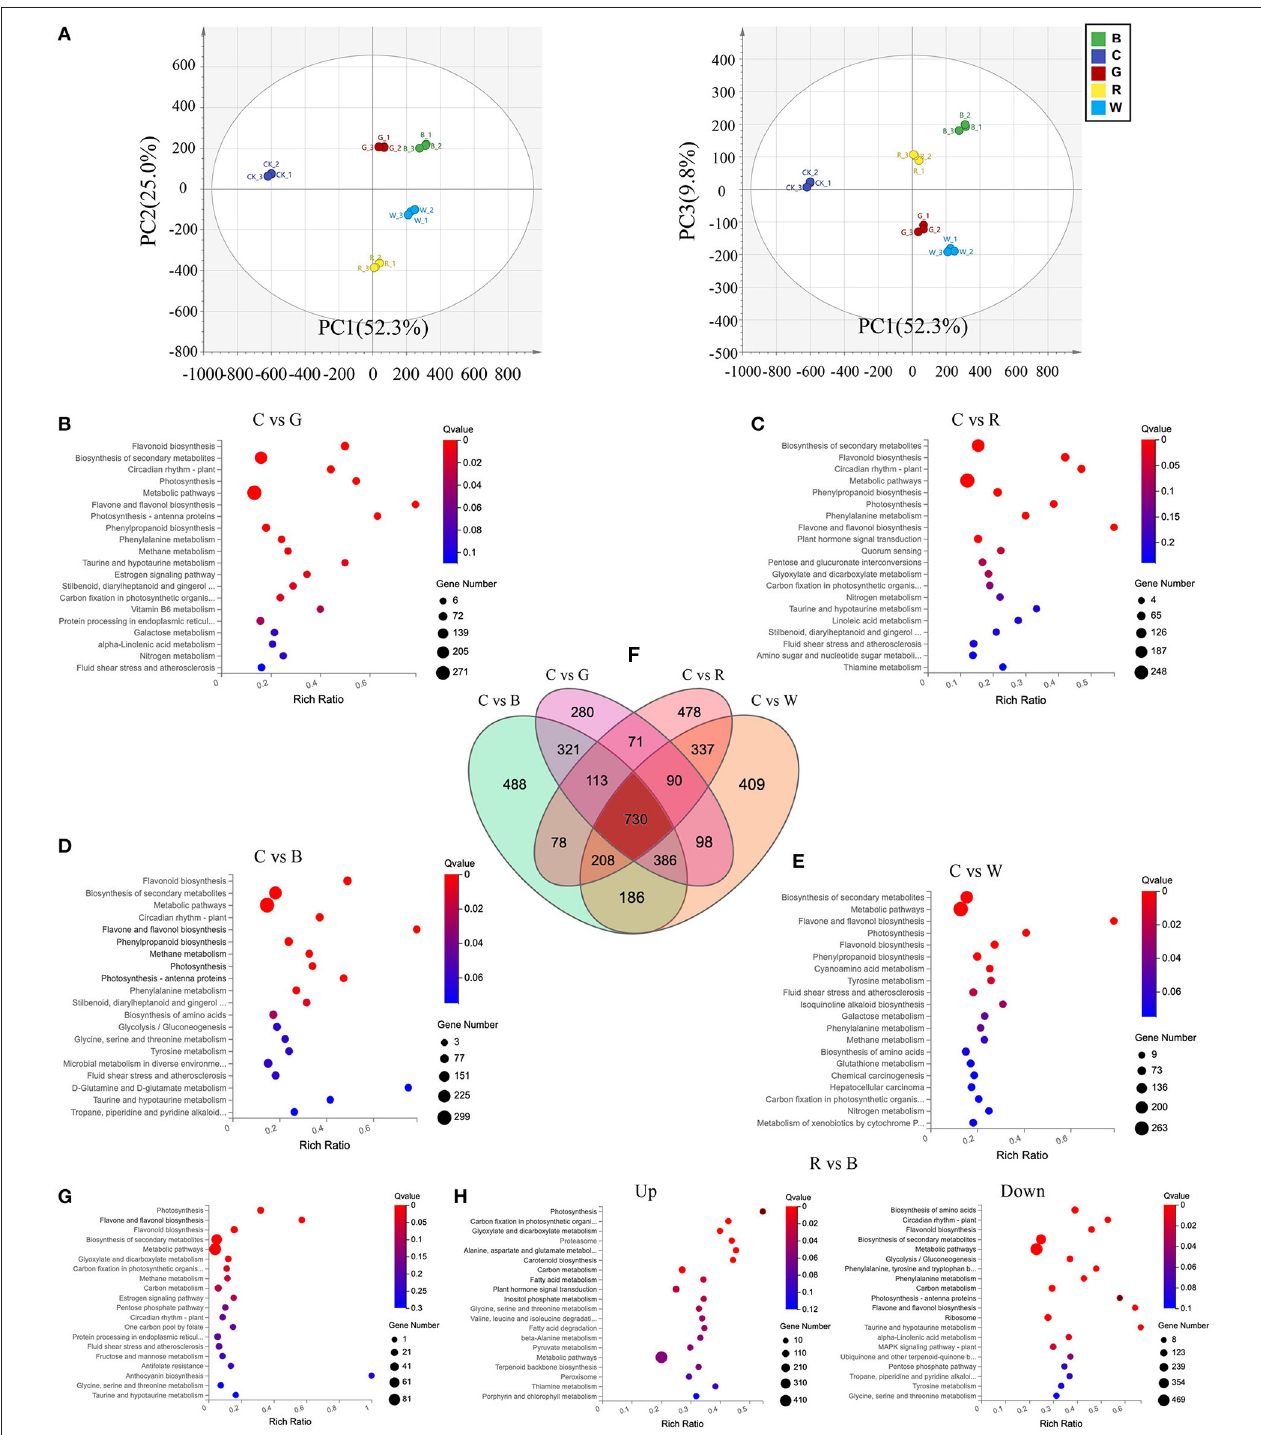
FIGURE 3 | Differential expressed genes (DEGs) in Cabernet Sauvignon after different light quality treatments. (A) Principal component analysis of the different light quality treatment based on the gene expression profiles. (B-E) KEGG enrichment analysis of the DEGs between C vs. G (B) , C vs. R (C) , C vs. B (D) , and C vs. W (E) . (F) Venn diagram showing the shared and unique DEGs between the four compared groups of peel samples. (G) KEGG enrichment analysis of the C vs. B, G, R, and W 730 DEGs. (H) KEGG enrichment analysis of the up-regulation and down-regulation DEGs between R vs. B. C: control (no light treatment), B: blue light treatment, R: red light treatment, W: white light treatment, G: green light treatment. DEGs were identified with the following parameters: p -value ≤ 0.05 and |log 2 FC (fold change) | ≥ 1.